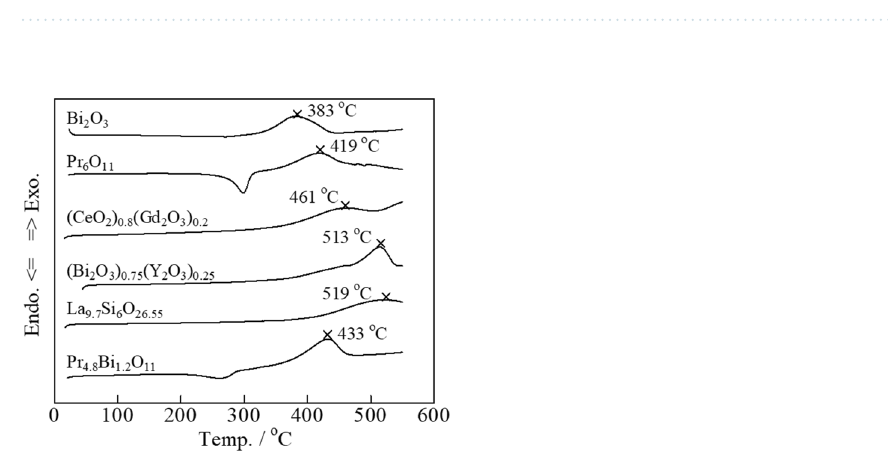
Figure 3. DSC curves of carbon black (2 wt%) mixed with the various Tl 2 O 3 ‒ 80 wt% added oxide composite catalysts.